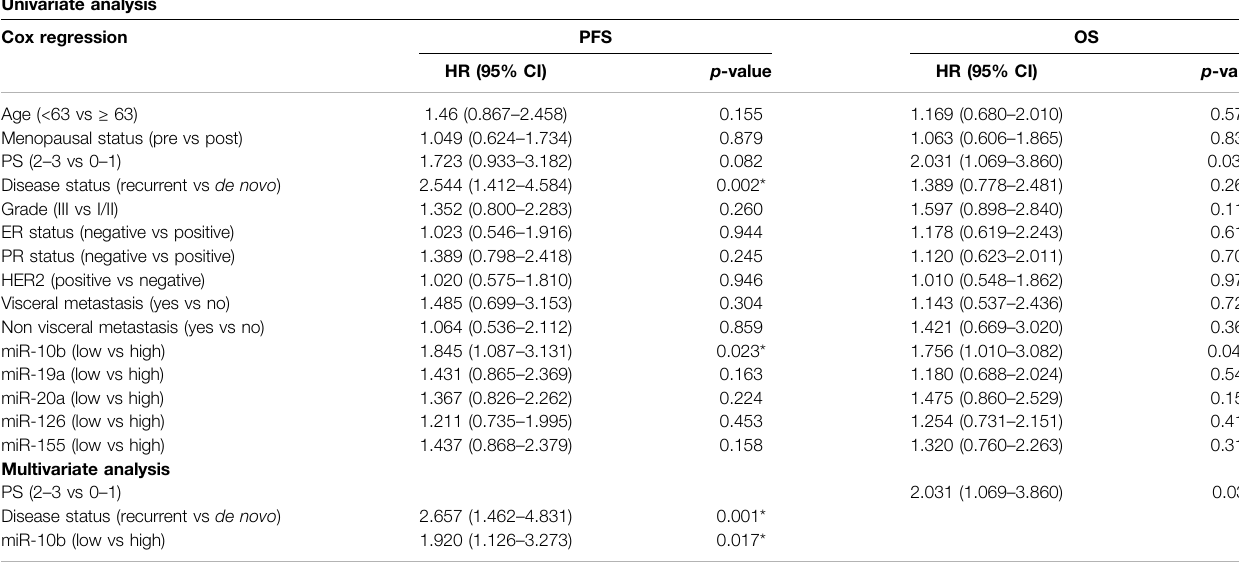
TABLE 3 | Univariate and multivariate analysis for PFS and OS in metastatic breast cancer patients ( n (cid:1) 64). Univariate analysis Cox